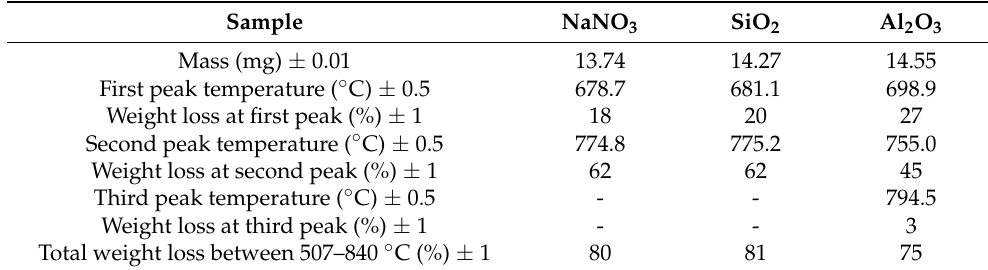
Table 3. Temperature and weight loss obtained by TGA measurements of pure NaNO 3 and NaNO 3 with SiO 2 and Al 2 O 3 NFs at 1% wt.